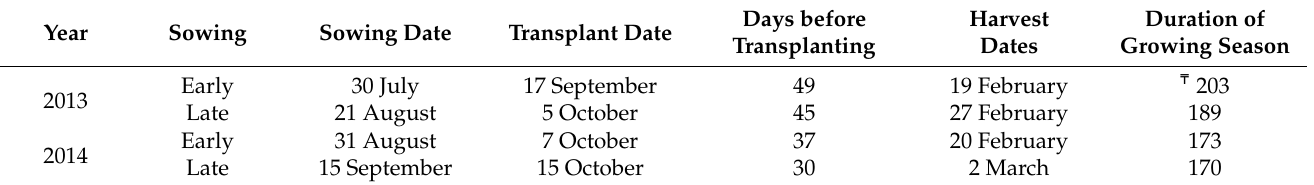
Table 1. Sowing date, transplanting date, harvest date, and duration of the growing season of dry-season sorghum grown at You é research farms in Chad in 2013 and 2014.